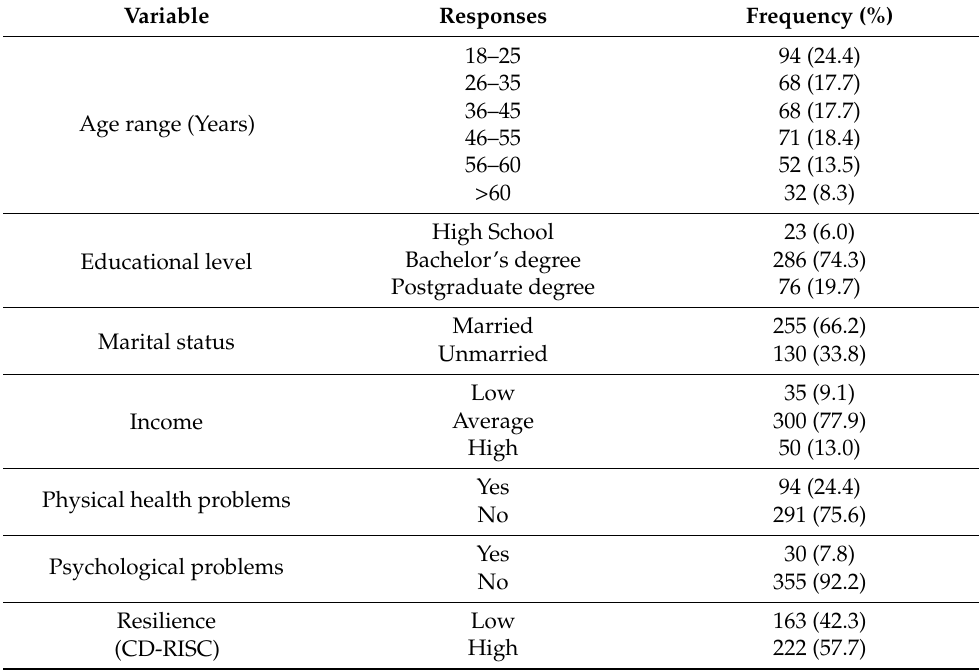
Table 1. Participant characteristics (N = 385).